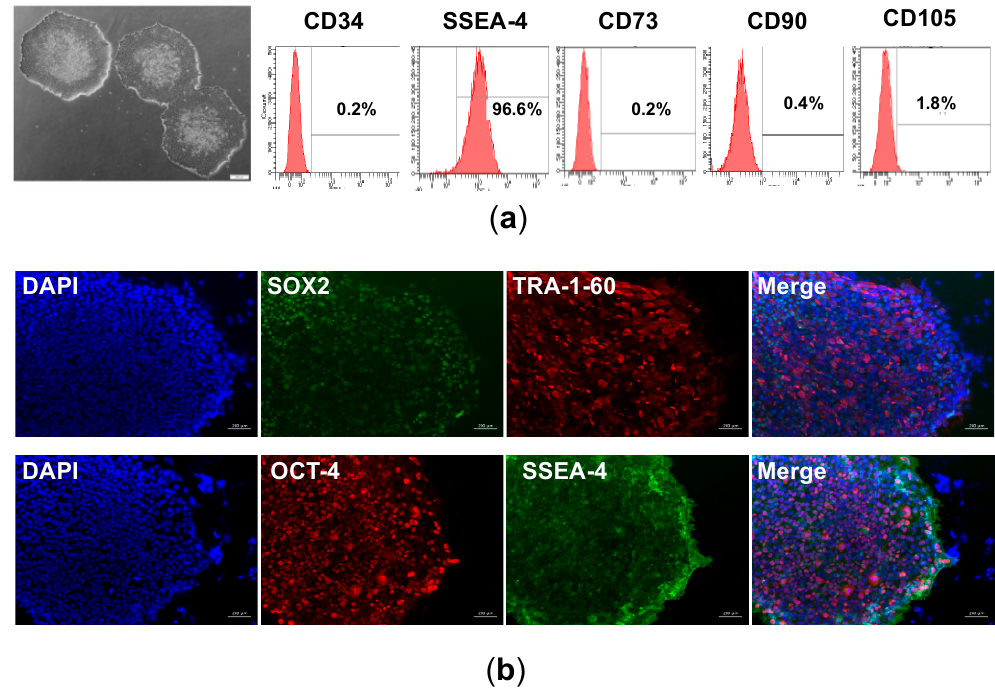
Figure A1. Characterization of iPSCs. ( a ) Light microscopic image and flow cytometry analysis of iPSCs. iPSCs were negative with typical MSC markers (CD73, CD90 and CD105) and endothelial/hematopoietic marker (CD34), while positive with pluripotency marker SSEA-4. ( b ) Immunofluorescence analysis of iPSCs with pluripotency markers. iPSCs were positive with SOX2, TRA-1-60, OCT-4 and SSEA-4. Scale bars are 200 µm. Nuclei were stained with DAPI for counterstaining.